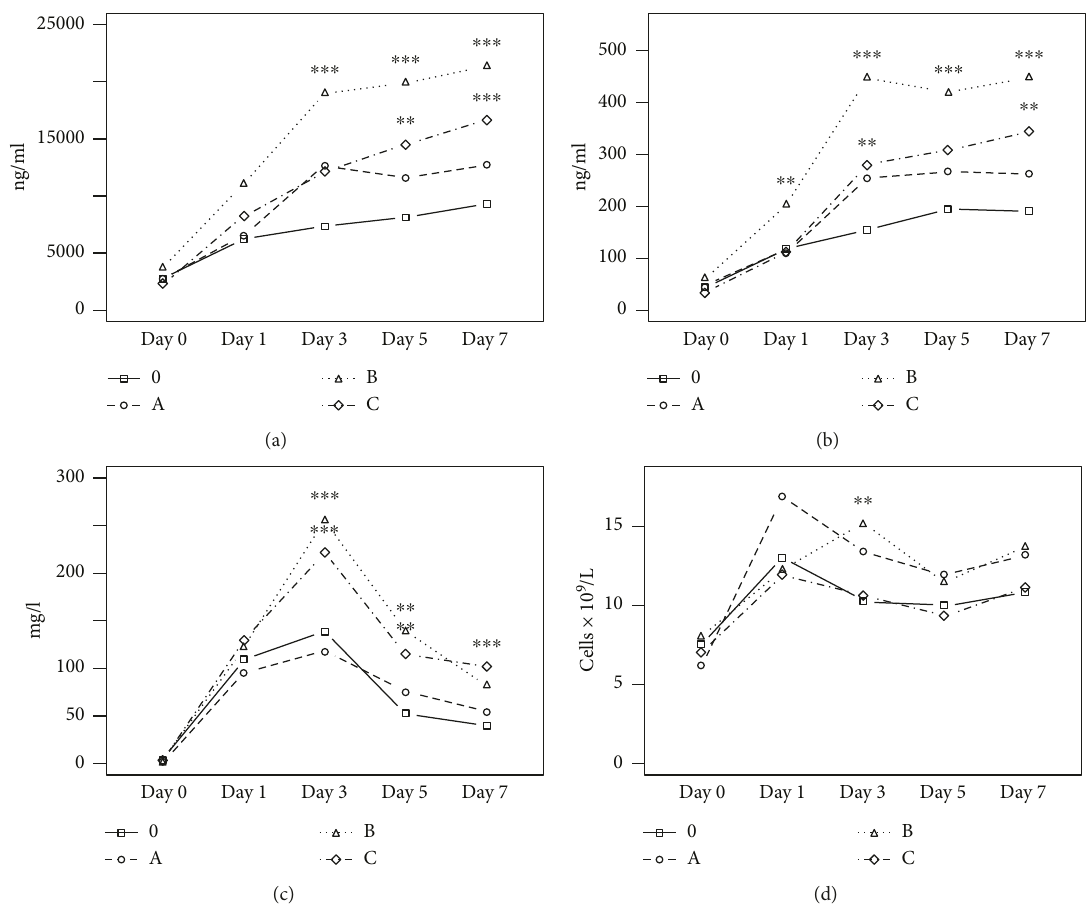
Figure 2: Kinetics of calprotectin (a), calgranulin C (b), C-reactive protein (c), and white blood cells (d) during the study period (0: uncomplicated course; A: POPF grade A; B: POPF grade B; C: POPF grade C; ∗∗ p < 0 01 ; ∗∗∗ p < 0 001 ).